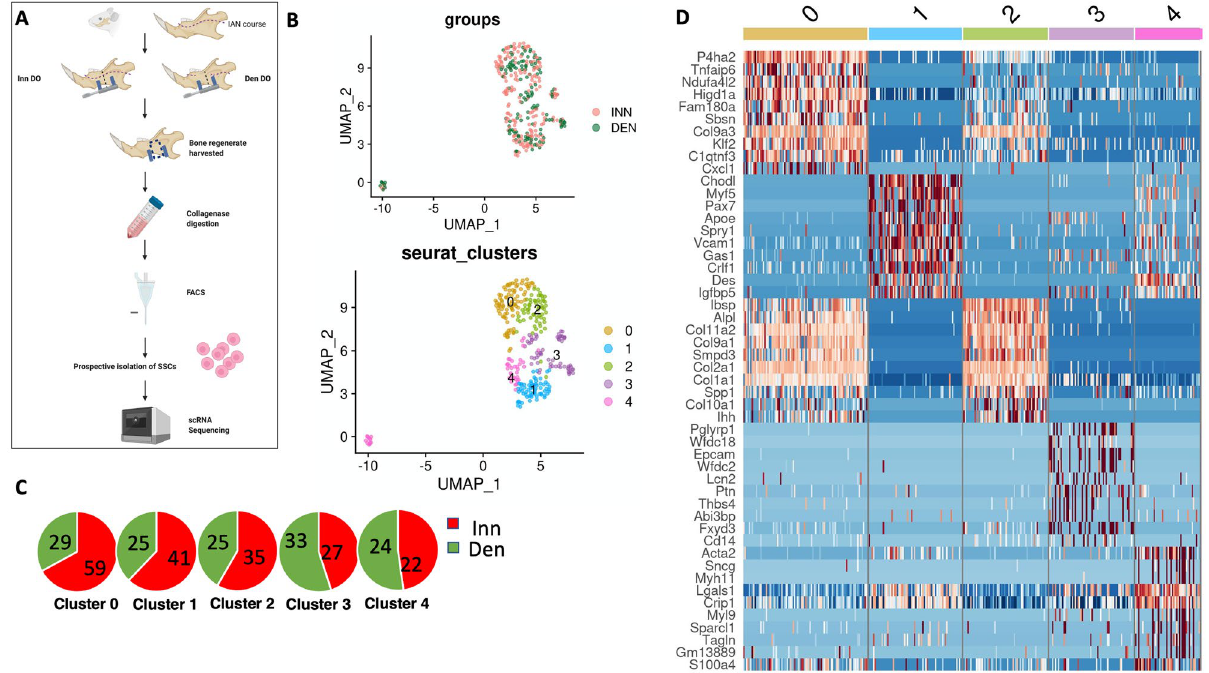
Figure 3. Single Cell RNA Sequencing Demonstrates Mandible IAN Innervation Affects SSC Transcriptional Priming. ( A ) Experimental schematic: Den DO and Inn DO mSSCs were isolated from mandible distraction regenerate at POD 15 and underwent single cell RNA sequencing using the 10X genomic platform. Created with BioRender.com. ( B ) Uniform manifold approximation and projection (UMAP) plot showing scRNA-seq data from (top) Inn DO (red) and Den DO (green) FACS-isolated mSSCs at POD 15. (Bottom) Five unique clusters of mSSCs are identified. Colors as labeled in the figure panel. ( C ) Pie chart demonstrating relative breakdown of representation of Inn DO mSSCs (red) versus Den DO mSSCs (green) in each cluster (left to right: 0, 1, 2, 3, 4). ( D ) Heat map representing top 10 differentially expressed genes characteristic to each of the five transcriptionally-defined clusters. Red: upregulation; blue: